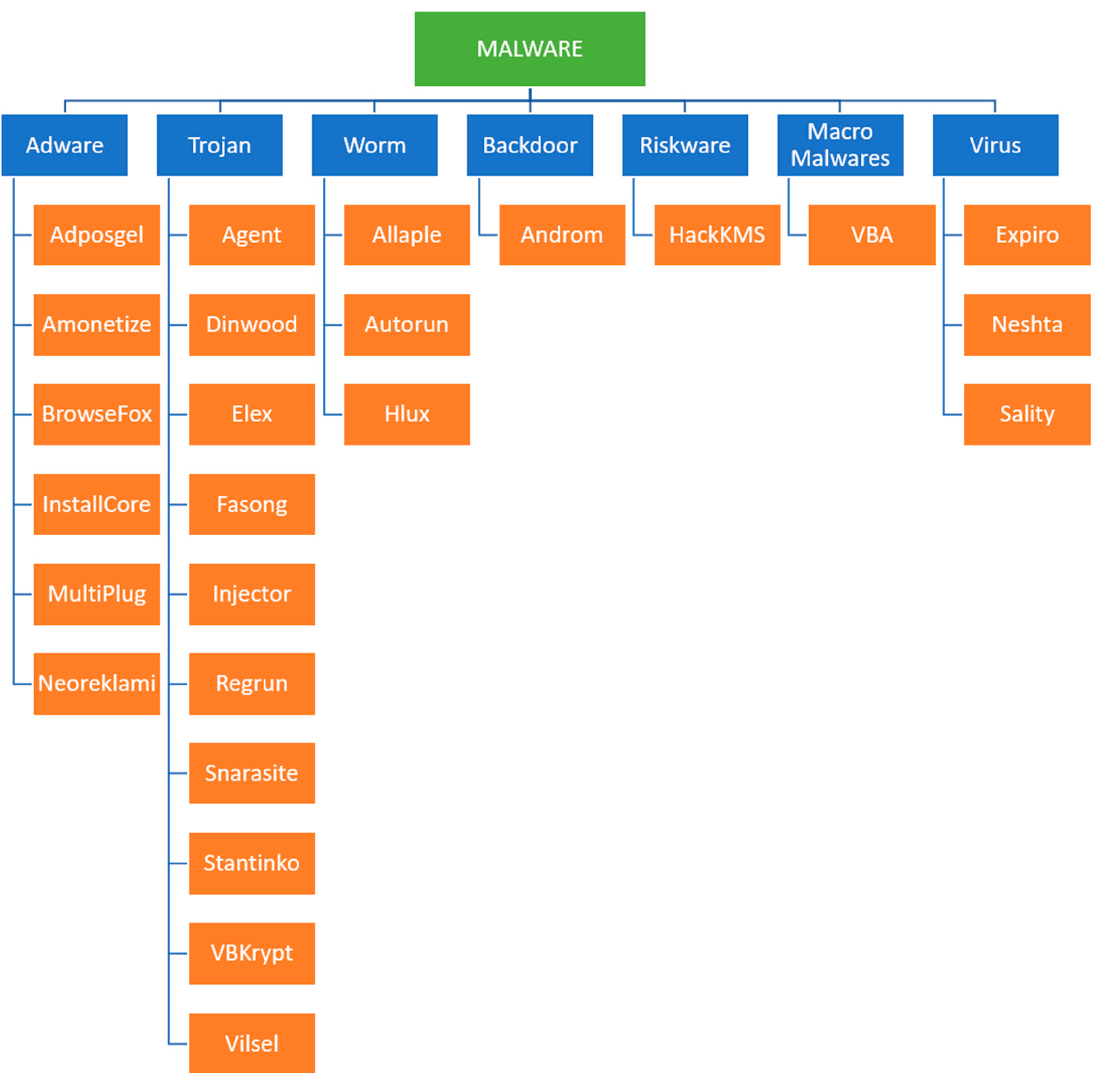
Figure 6. Distribution of samples across various malware classes loaded in the datasets.